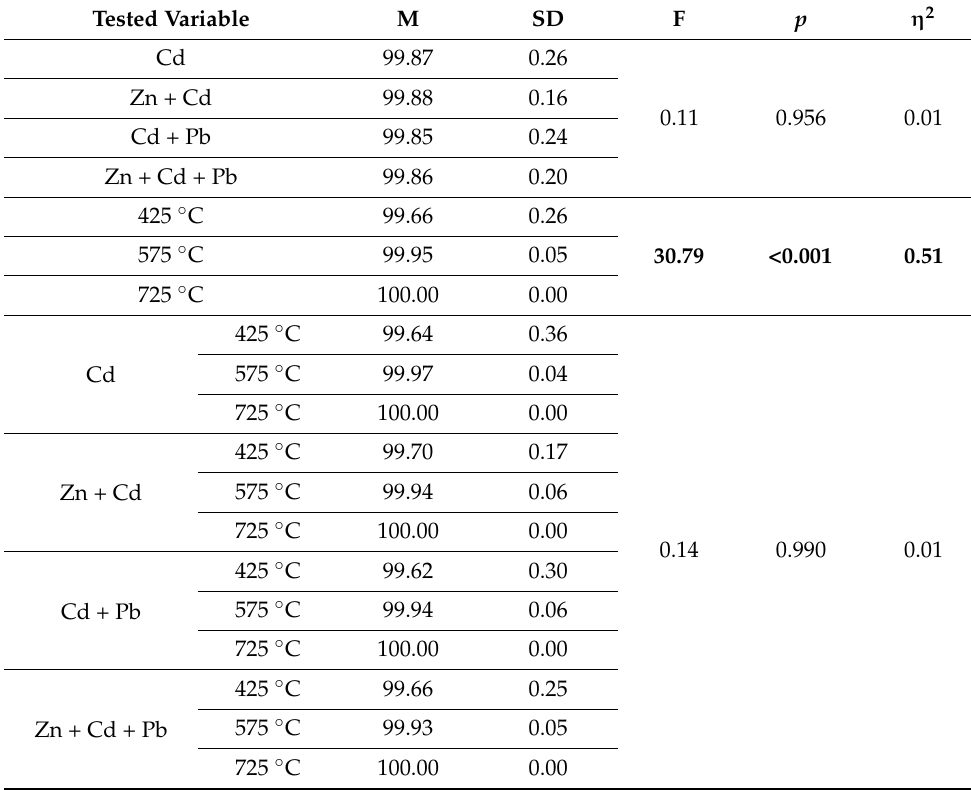
Table 12. Statistical analysis for sorption of Cd (% of removal) in regard to metal combination in the solution and the pyrolysis temperature.